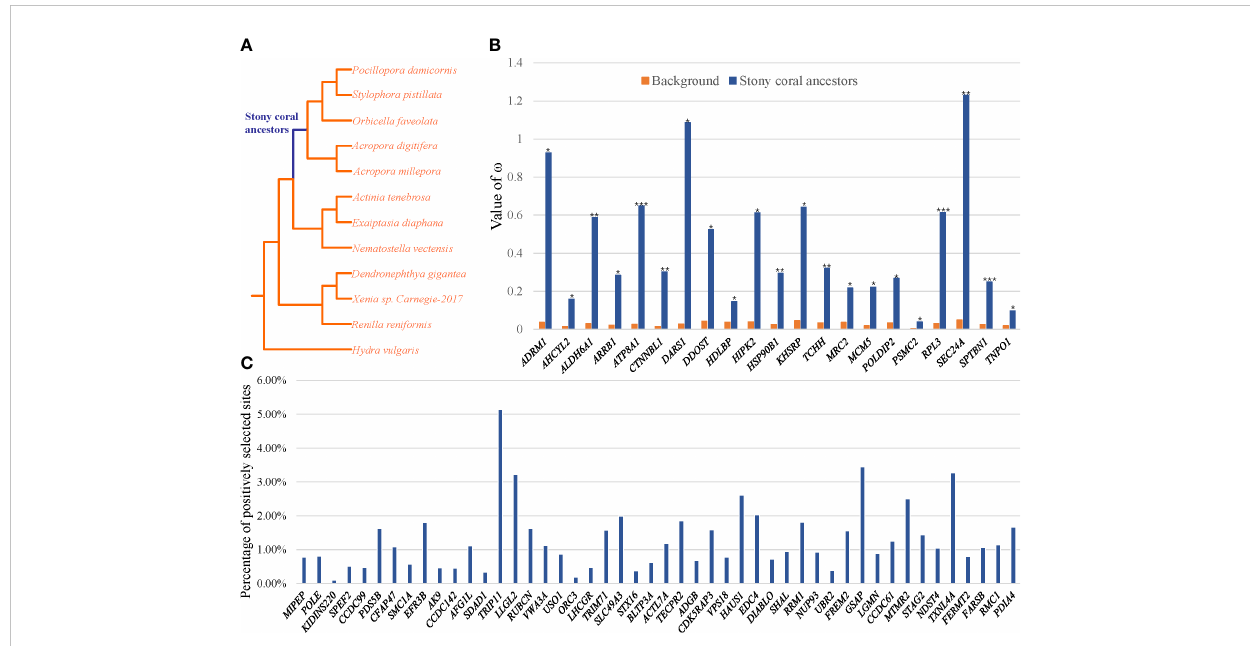
FIGURE 2 (A) The phylogenetic tree used in the selection analysis, with stony coral ancestors as the foreground branch. (B) The REGs of stony coral ancestors. (C) The PSGs of stony coral ancestors. The vertical axis represents the percentage of the number of positively selected sites for each